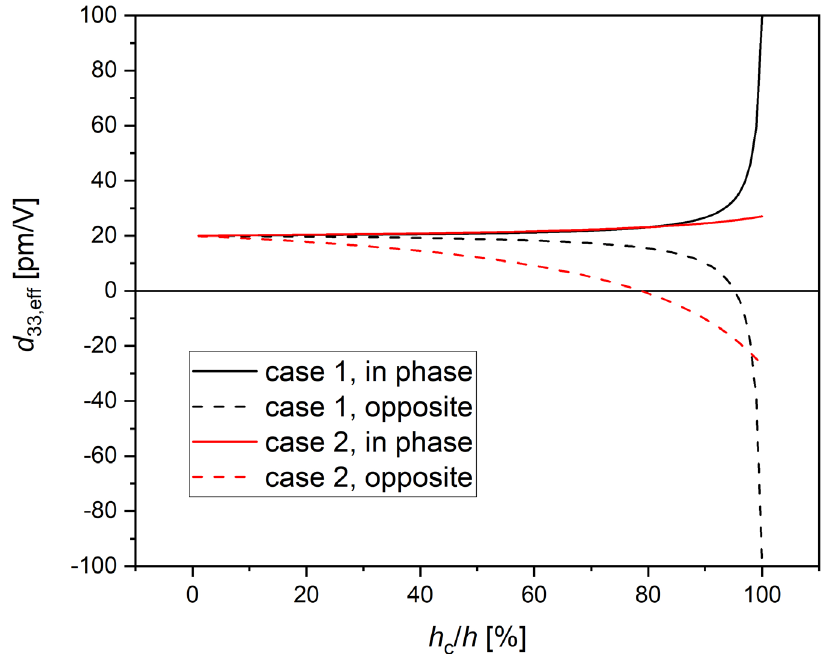
Figure 5. Dependence of the overall displacement for 1 V electric potential ( d 33,eff ) from the relative thickness h c / h of the two layers (crystal and polymer) considered in the simple picture leading to Equation (2). Black curves (case 1): ε c = 1000, ε p = 10, d c = 100 pm/V, d p = 20 pm/V; red curves (case 2): ε c = 50 [40], ε p = 10, d c = 27 pm/V [41], d p = 20 pm/V. Solid curves: case of same orientation of the polar axes of crystal and polymer; dashed curves: case of opposite orientations.